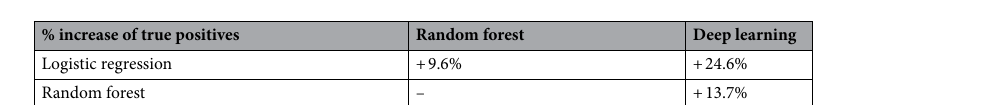
Figure 5. Deep learning model ( a ) area under the curve and ( b ) calibration curves for five outer validation folds. AUC—area under the curve.